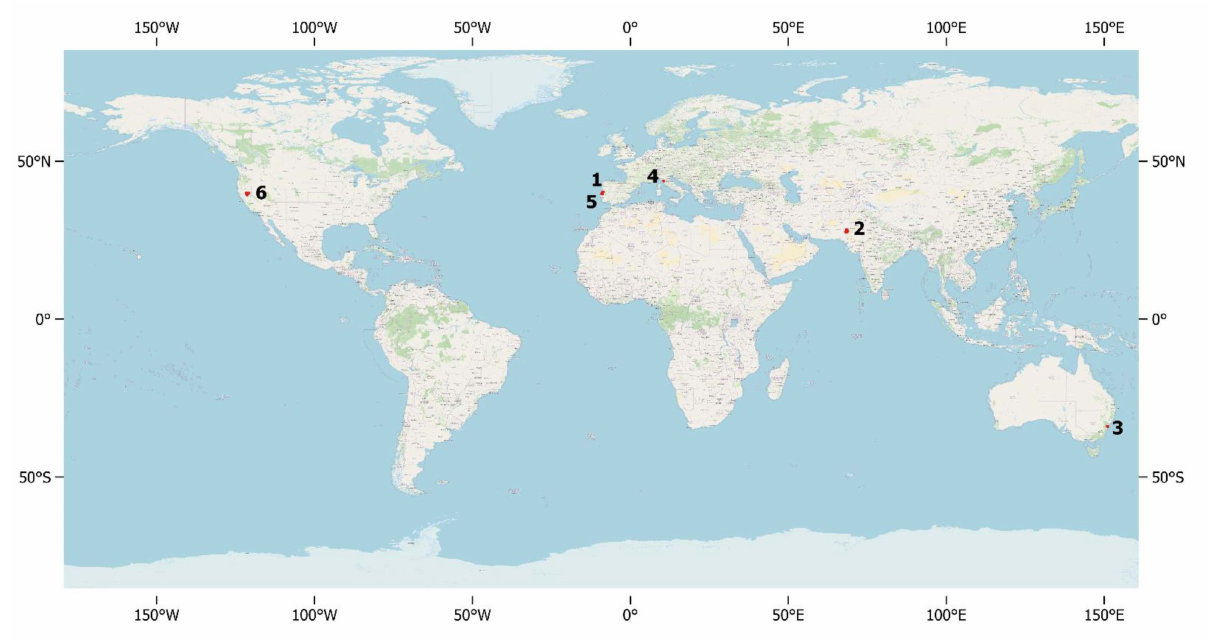
Figure 2. Location of study areas used for demonstrating the MINDED-FBA tool: ( 1 ) Mondego flood (Central Region, Portugal); ( 2 ) Sindh Province floods (Pakistan); ( 3 ) Richmond flood (New South Wales State, Australia); ( 4 ) Monte Pisano fire (Tuscany Region, Italy); ( 5 ) Leiria National Forest fire (Central Region, Portugal); ( 6 ) North-Complex fire (California State, USA) (Coordinate Reference System: